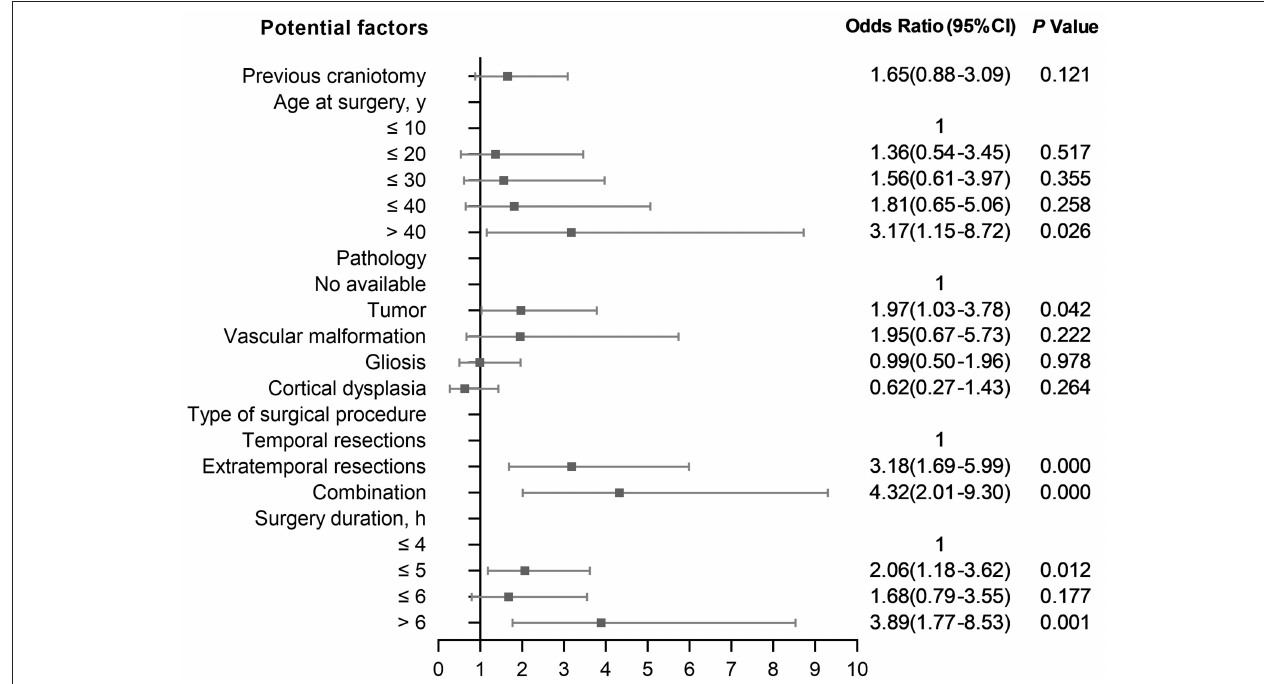
FIGURE 3 | Risk factors for severe complications compared with no complications.